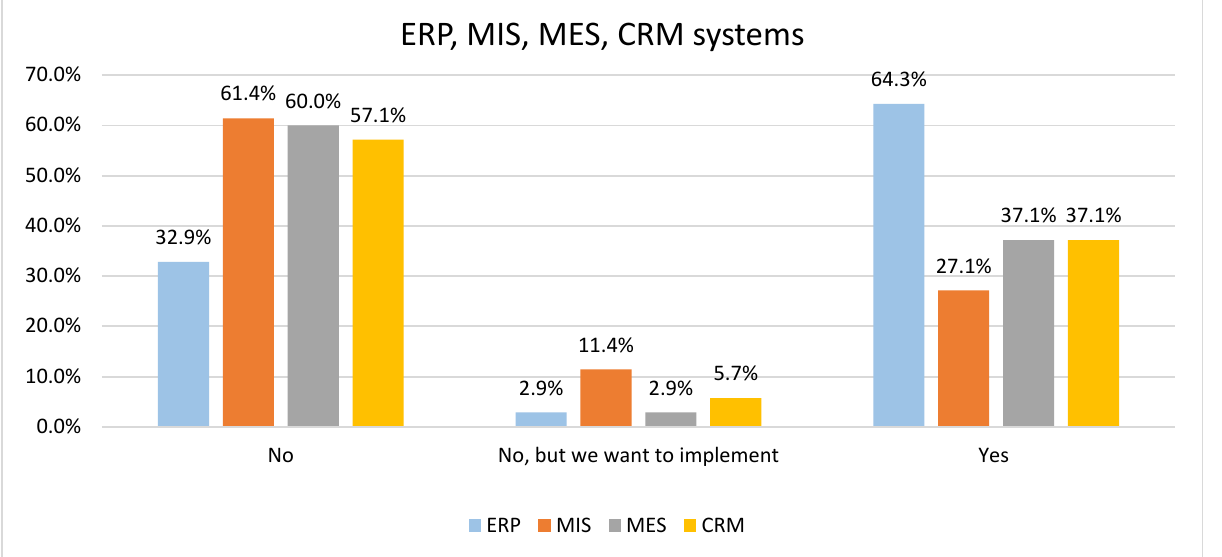
Figure 9. ERP, MIS, MES, CRM systems utilization in the studied companies. Figure 10 focuses on systems utilization in production companies. It can be seen that 78.8% of production companies have an ERP system implemented, and only 17.3% of production companies have no ERP system.